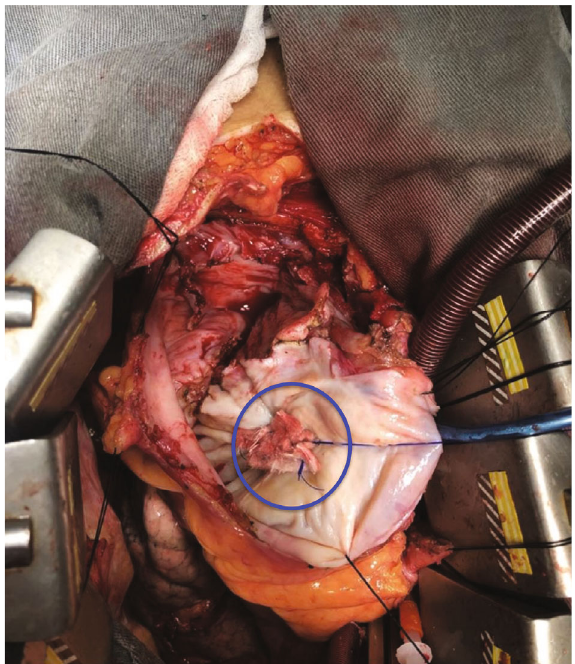
Figure 5: Intraoperative view. Suture of the myocardial rupture and pseudoaneurysm using linear te fl on tissue (blue